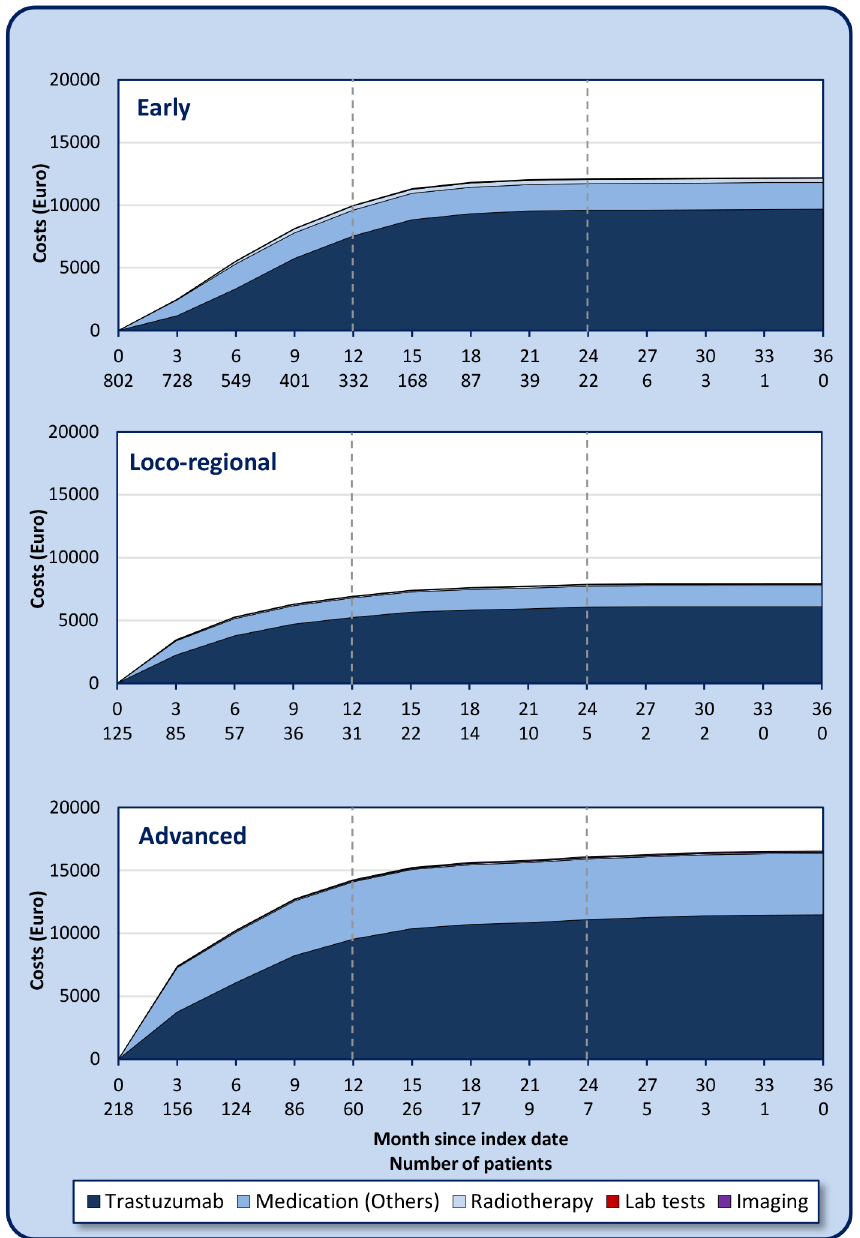
Fig 3. Cumulative outpatient main healthcare care costs since the index dates in different health states of HER2-positive breast cancer in Iran, during a 3-year follow-up period (21.3.2011–20.3.2014).